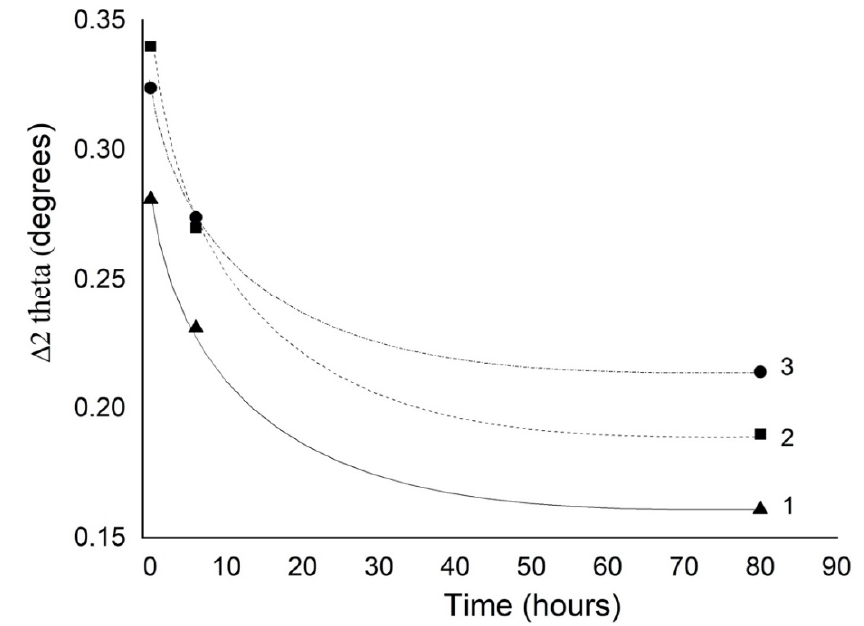
Figure 3. The reflexes shifting of the X-ray di ff raction pattern of dicalcium phosphate dihydrate when aging in the mother solution: 1—20.95 degrees, 2—11.65 degrees, 3—29.30 degrees. The precipitate was synthesized at pH 3.8, temperature 15 ◦ C, and initial ratio Ca / P = 0.5.